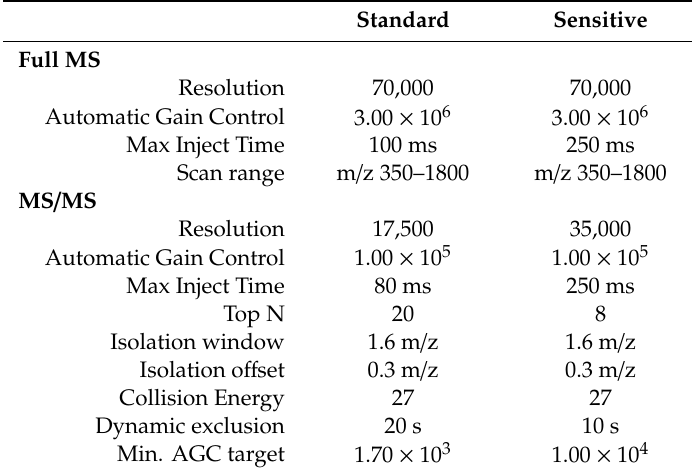
Table 1. Settings issued for the standard vs. sensitive acquisition methods.